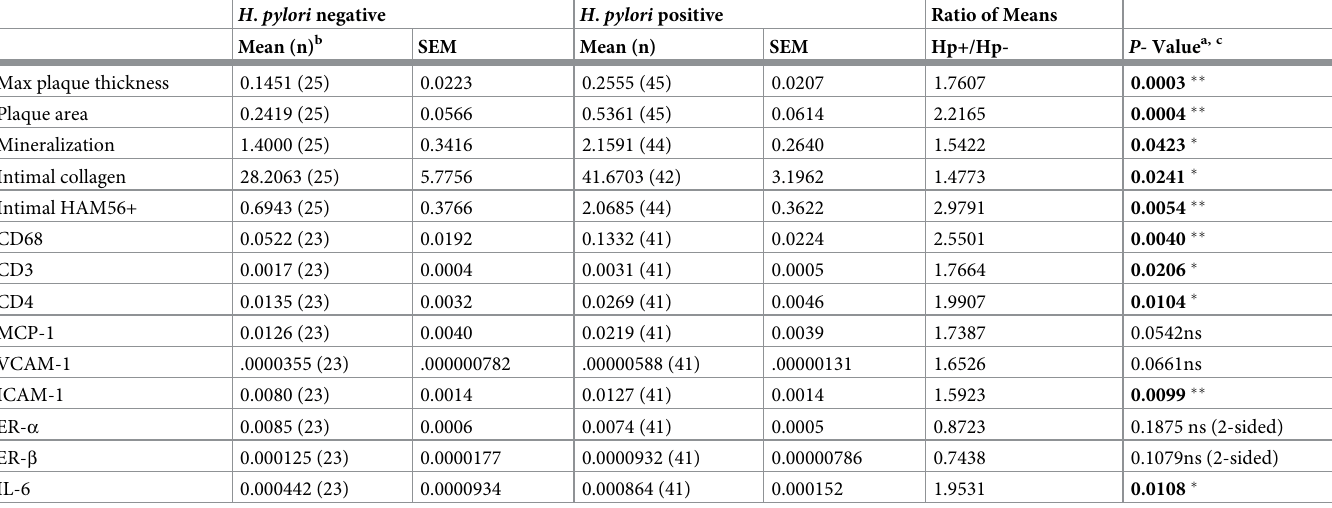
Table 1. Premenopausal iliac artery plaque parameters and inflammatory biomarkers. H . pylori negative